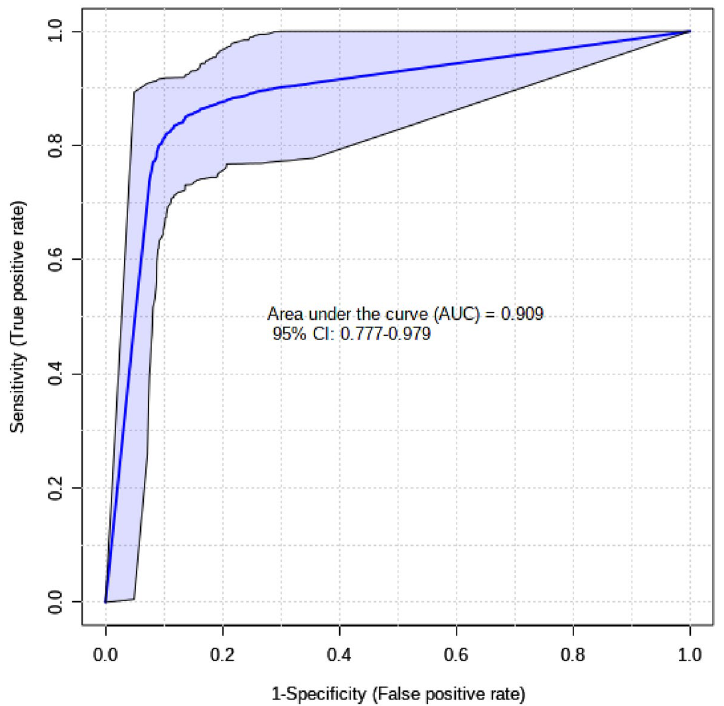
Figure 1. Receiver operating characteristics (ROC) curve of biomarkers of sheep pregnancy. The panel of five metabolites (methanol, l-carnitine, d-glucose, l-arginine, urea) from the CNT vs PRG comparison were selected as significant (p-value < 0.05) biomarkers of sheep pregnancy.